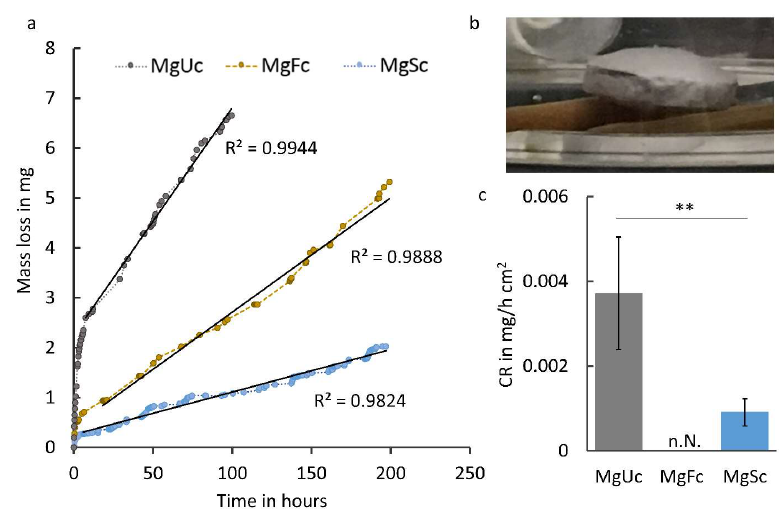
Figure 5. Corrosion behavior of uncoated (MgUc), spin-coated (MgSc), and electrospun fiber-coated magnesium (MgFc): ( a ) representative mass loss curves with linear regression (black lines) after the initial phase; ( b ) bubble formation underneath the fiber coating during corrosion; ( c ) normalized corrosion rate calculated from the linear regression (n.N.—not named) (“ns”—not significant, * p < 0.05, ** p < 0.01) ( n = 4).